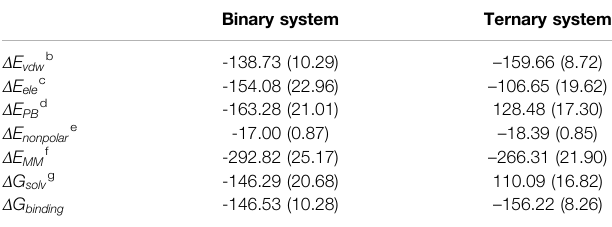
TABLE 2 | Binding free energy (kcal/mol) analysis between K-Ras4B G13D and SOS cat .